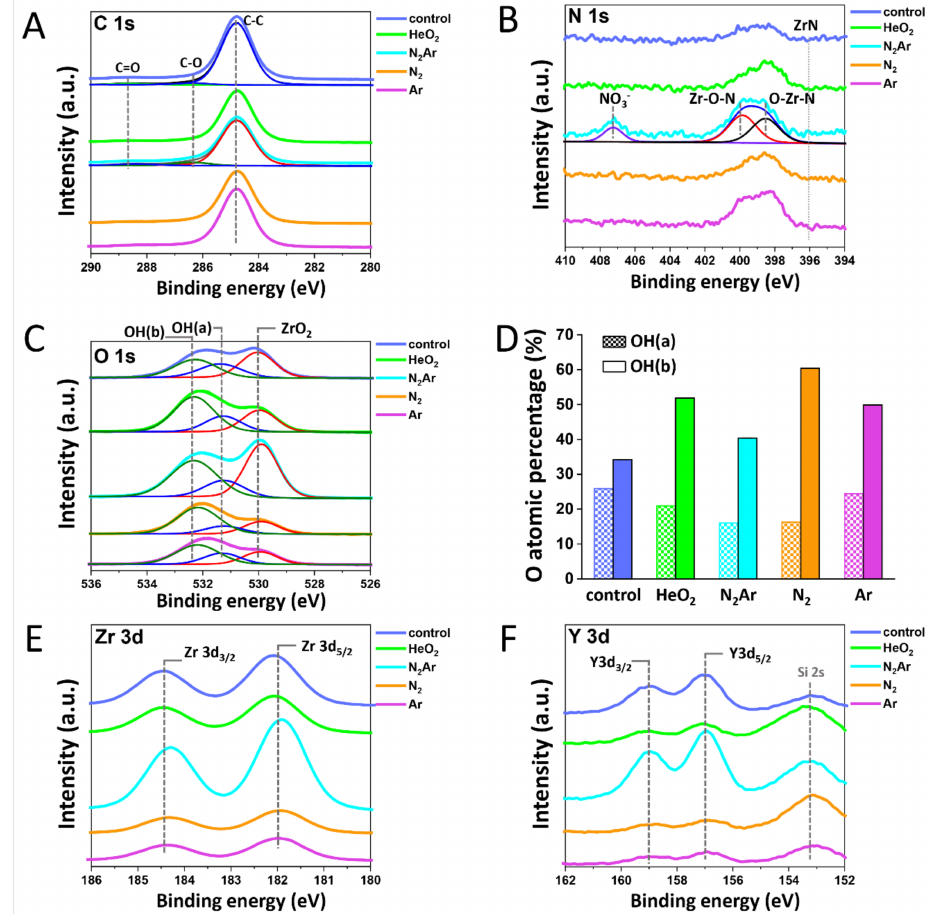
Figure 2. ( A ) C 1s; the carbon content was found to be a remarkable reduction in the N 2 /Ar group compared to those in other groups. ( B ) N 1s; a new component appeared at a binding energy of 406.5 eV in the N 2 /Ar group, which was associated with the presence of nitrate (NO 3 − ) species. ( C ) O 1s XPS spectra; ( D ) Percentage areas of acidic hydroxyl OH(a) and basic hydroxyl OH(b) in O 1s spectra; ( E ) Zr 3d; and ( F ) Y 3d XPS spectra on outermost surfaces of zirconia with different plasma gases.